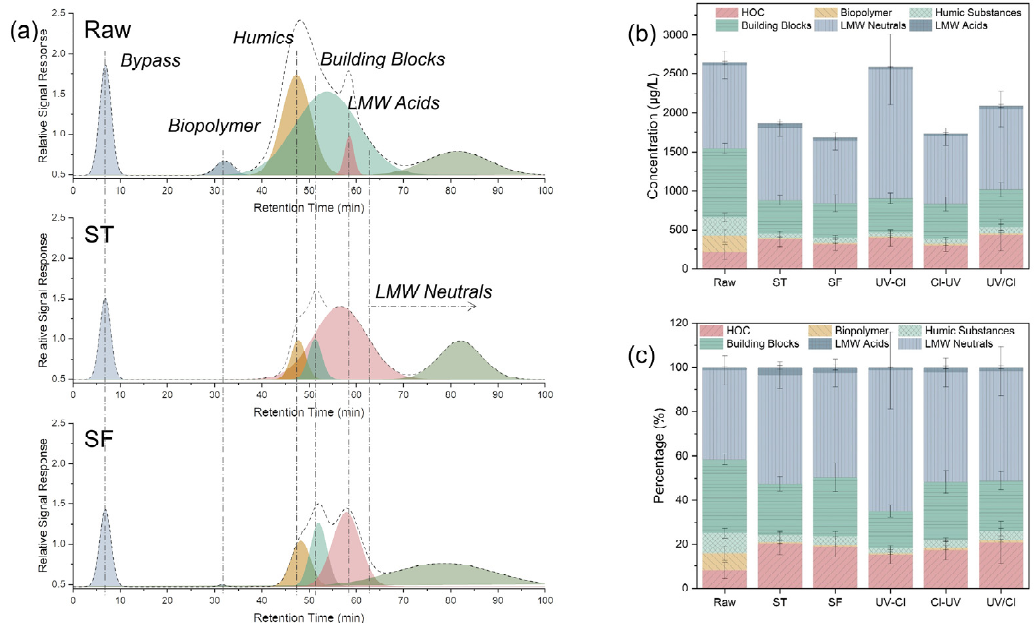
Figure 3. Shift of LC-OCD component diagram in pre-treatment processes ( a ); Change of LC-OCD components concentration ( b ) and percentage ( c ).